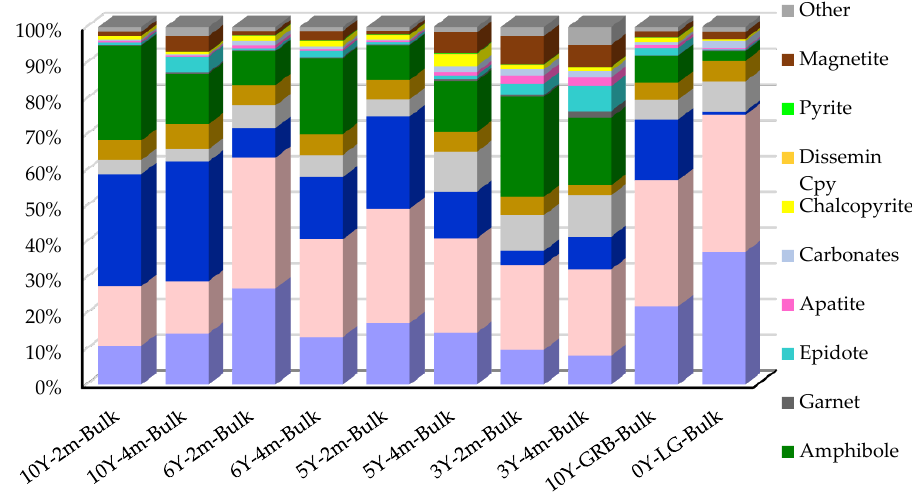
Figure 6. Mineralogical modal composition (wt.%) of the bulk samples.